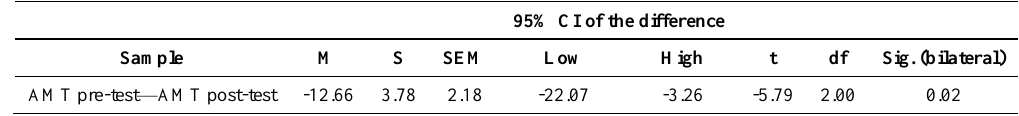
Table 3. Paired sample test.